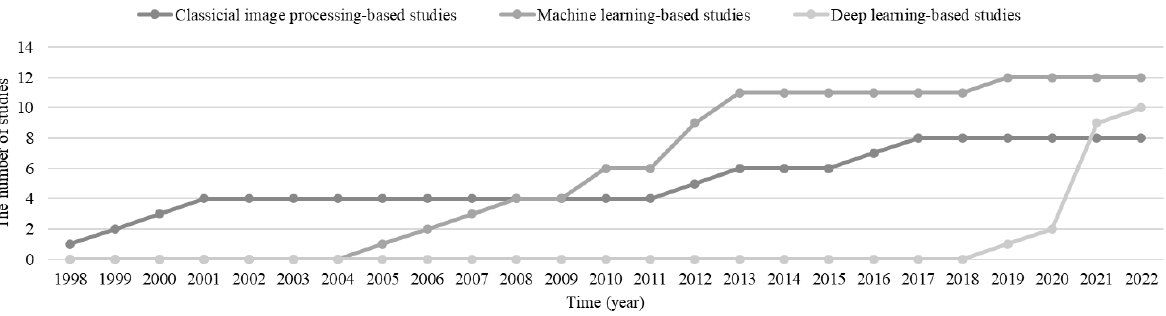
Figure 9. The increasing trends of the Included Study by method categories (the classical image processing-based studies, machine learning-based studies, and deep learning-based studies).